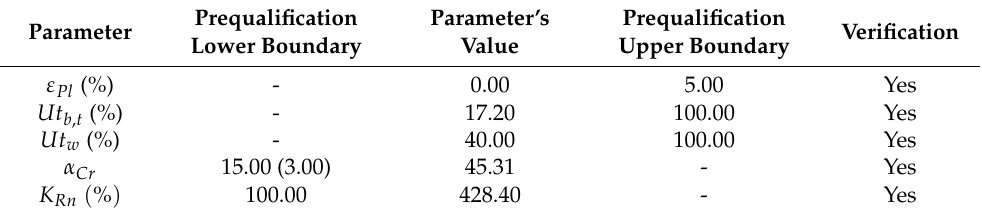
Table 5. Essential results of the 8ES EPC CP-DP-ST model.